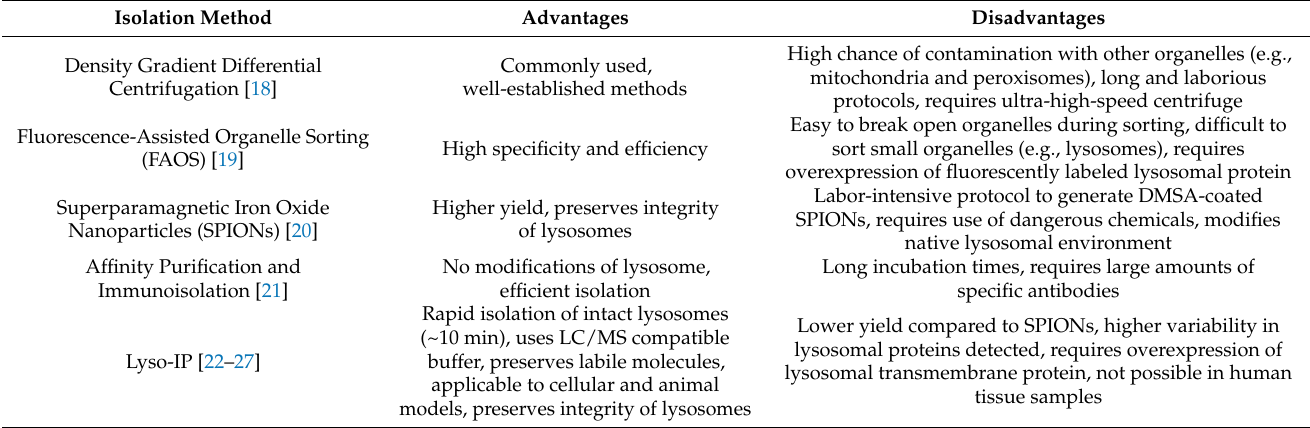
Table 1. Summary of the most common laboratory techniques for lysosomal isolation from eukaryotic cells. Detailed protocols can be found in the Methods section of each